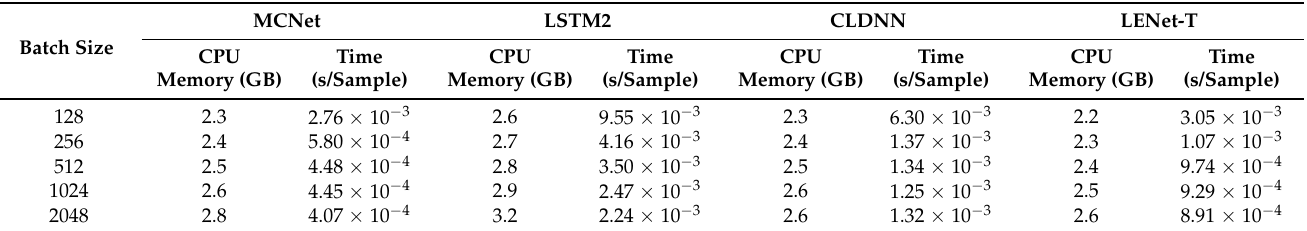
Table 12. Results of inference using the CPU on the P4 platform.